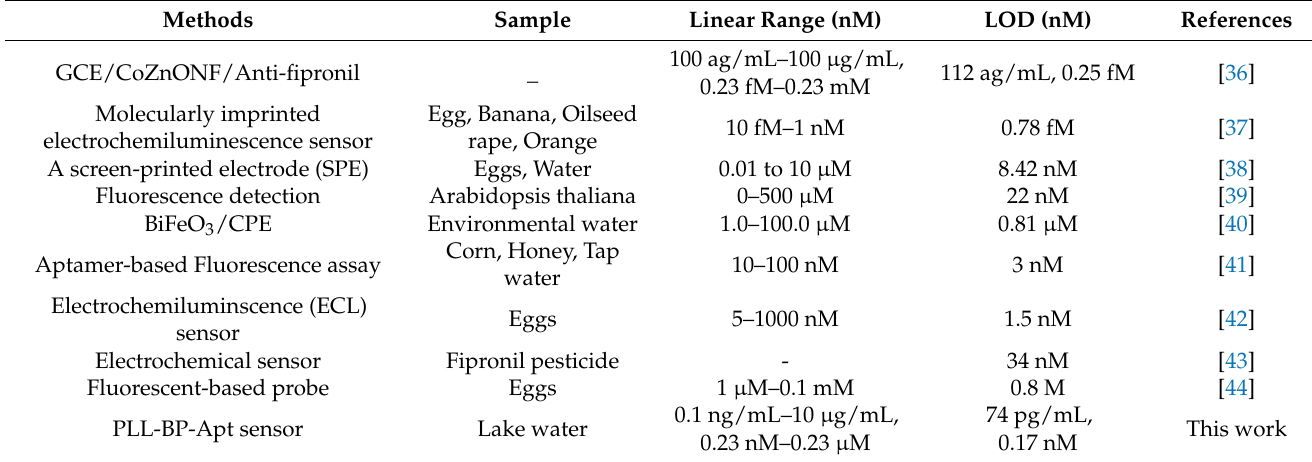
Table 2. Comparison of the analytical performance with other